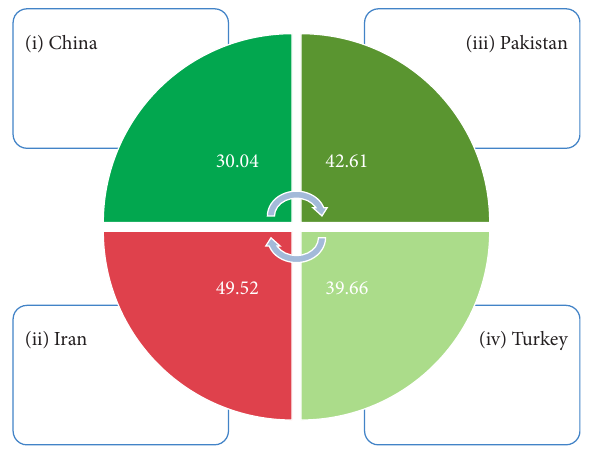
Figure 7: Crime index of four countries in 2019. Source: https:// www.numbeo.com/crime/country_result.jsp? (NUMBEO).